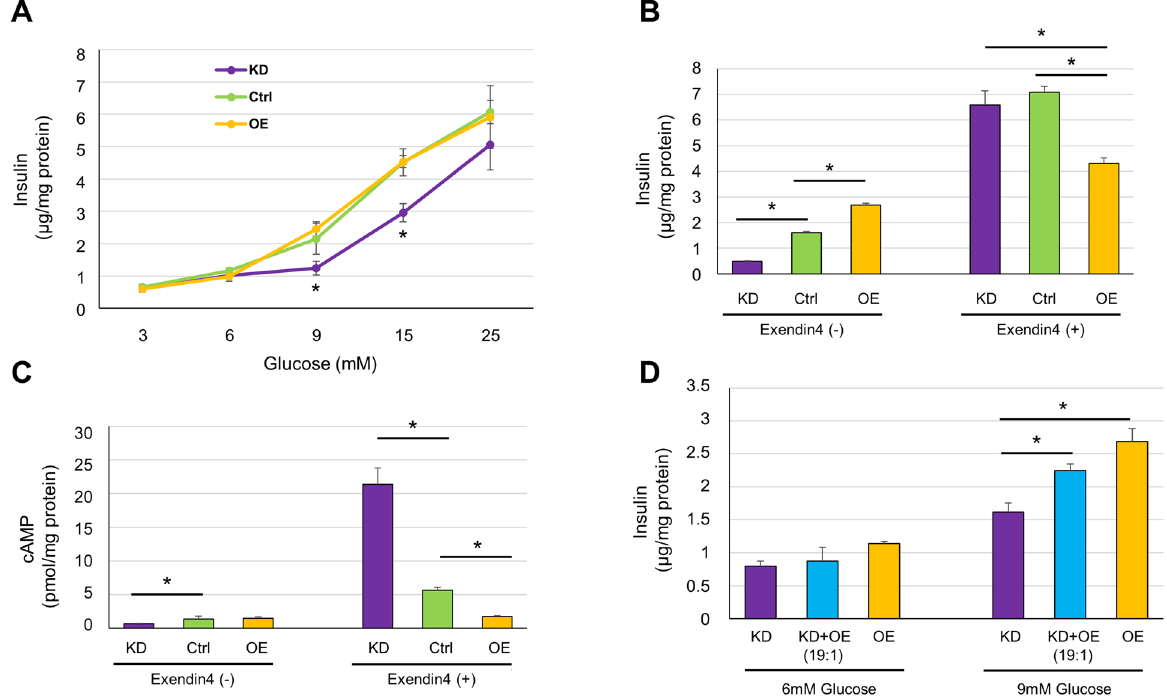
Figure 3. Gcg expression levels severely affect the regulation of insulin secretion. ( A ) Insulin secretion from MIN6-CB4-Gcg KD , CB4-ctrl, and CB4-Gcg OE cells stimulated with 3, 6, 9, 15, or 25 mM glucose. CB4- Gcg KD cells showed considerably lower secretion than the other cell lines at 9 and 15 mM glucose. Values are means ± S.D. (n = 6). * P < 0.05 by Tukey’s test. ( B ) Potentiation of GSIS by exendin-4. MIN6-CB4-Gcg KD , CB4- ctrl, and CB4-Gcg OE cells were stimulated with 9 mM glucose in the presence or absence of 20 nM exendin-4 for 30 min and secreted insulin levels were measured. Values are means ± S.D. (n = 3). * P < 0.05 by Tukey’s test. CB4- Gcg OE cells secreted more insulin than CB4-ctrl cells in the absence of exendin-4 as also seen in Fig. 3A (9 mM glucose). However, the significance level was different ( P > 0.05 in A ; P < 0.05 in B ). The reason for this difference is elusive, but it may be due to the difference in the stimulation period (60 min in A ; 30 min in B ). ( C ) Cellular cAMP levels after exendin-4 treatment. MIN6-CB4-Gcg KD , CB4-ctrl, and CB4-Gcg OE cells were stimulated with 9 mM glucose in the presence or absence of exendin-4 for 30 min and cellular cAMP levels were measured. Values are means ± S.D. (n = 3). * P < 0.05, versus cAMP levels in CB4-ctrl cells by Dunnett’s test. ( D ) Paracrine effect of GLP-1 secreted from CB4-Gcg OE on CB4-Gcg KD cells. CB4-Gcg OE and CB4-Gcg KD cells were mixed at a ratio of 1:19, cultured for 4 days and subjected to GSIS experiment. A small proportion of CB4-Gcg OE cells clearly enhanced the insulin secretion from CB4-Gcg KD cells at 9 mM glucose. Values are means ± S.D. (n = 3). * P < 0.05 by Tukey’s